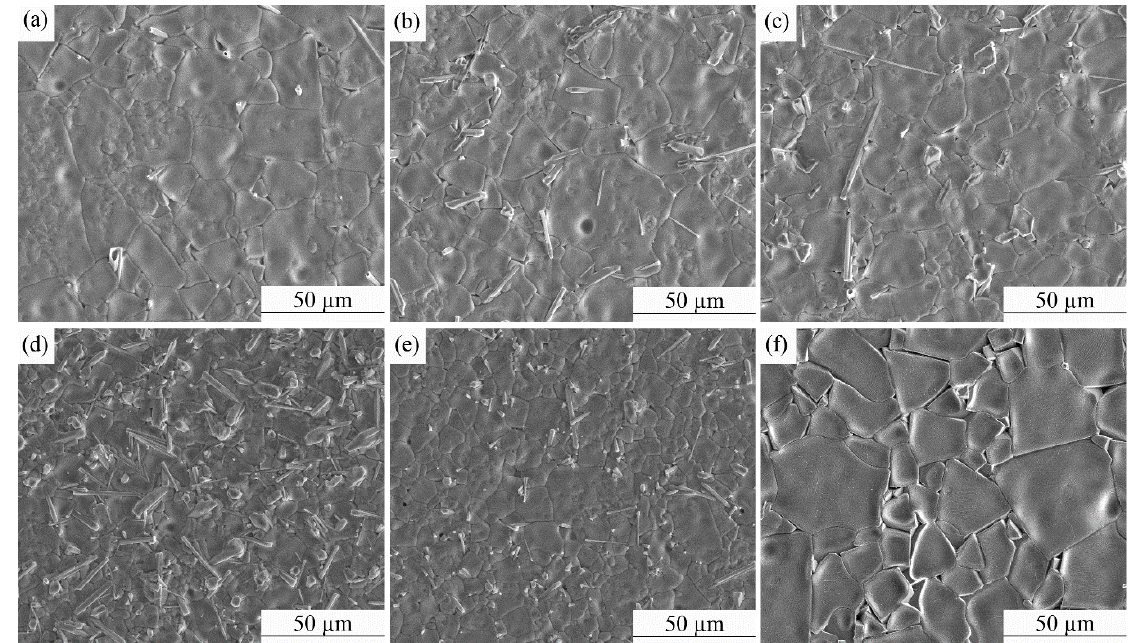
Figure 5. SEM images of the (1– x )CLT- x NMT ceramics (1550 °C, 30 min): ( a ) x = 0.35, ( b ) x = 0.40, ( c ) x = 0.45, ( d ) x = 0.50, ( e ) x = 0.55, ( f ) x = 0.60.